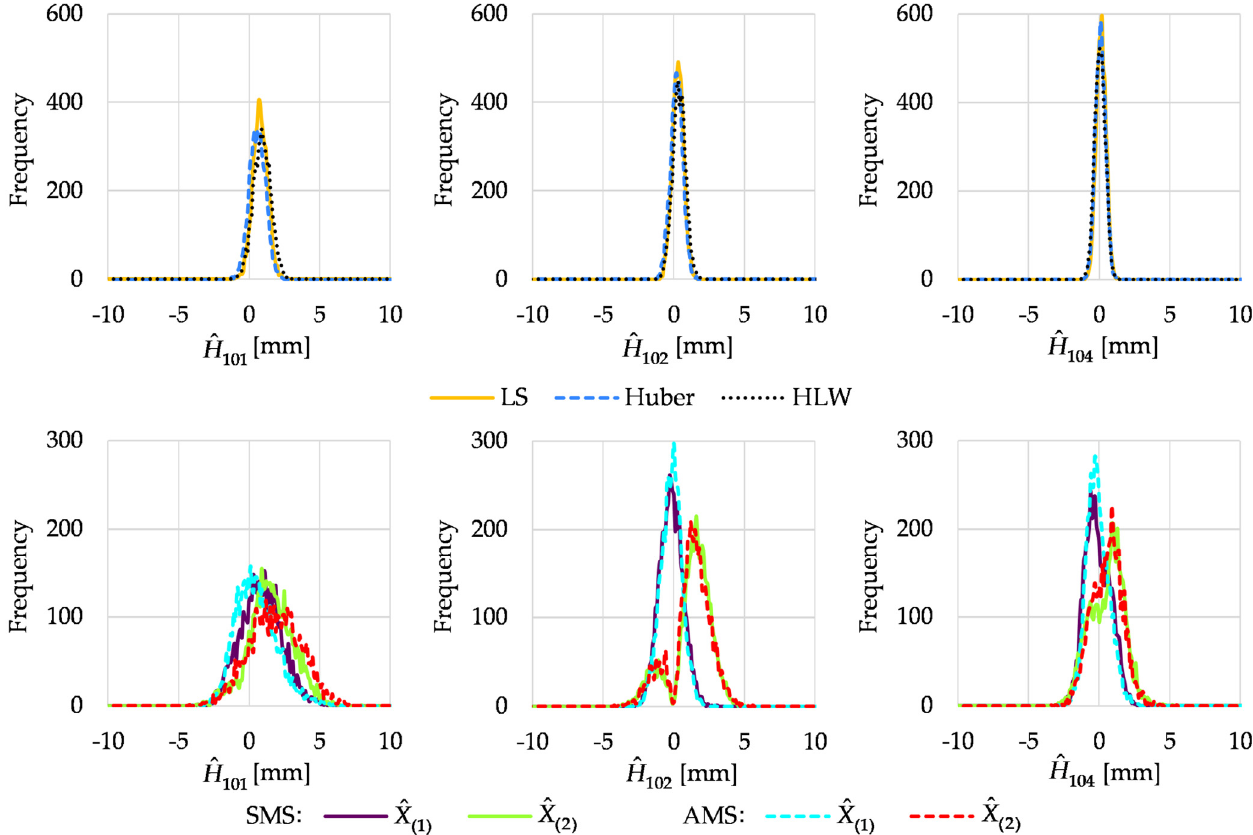
Figure 4. Histograms of estimated point heights in Variant III.